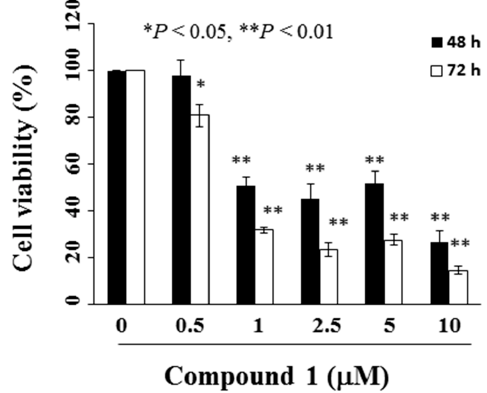
Figure 2. Inhibitory effects of compound 1 on viability of MCF-7 breast cancer cells. Cells were treated with compound 1 at the indicated concentrations for 48 and 72 h, and cell viability was determined by MTT assay. Data are mean ± standard deviation (SD, n = 6). * p < 0.05 and ** p < 0.01 compared to control Table 1. Antiproliferative activities of compounds 1 and 3–8 against different cancer cell lines.